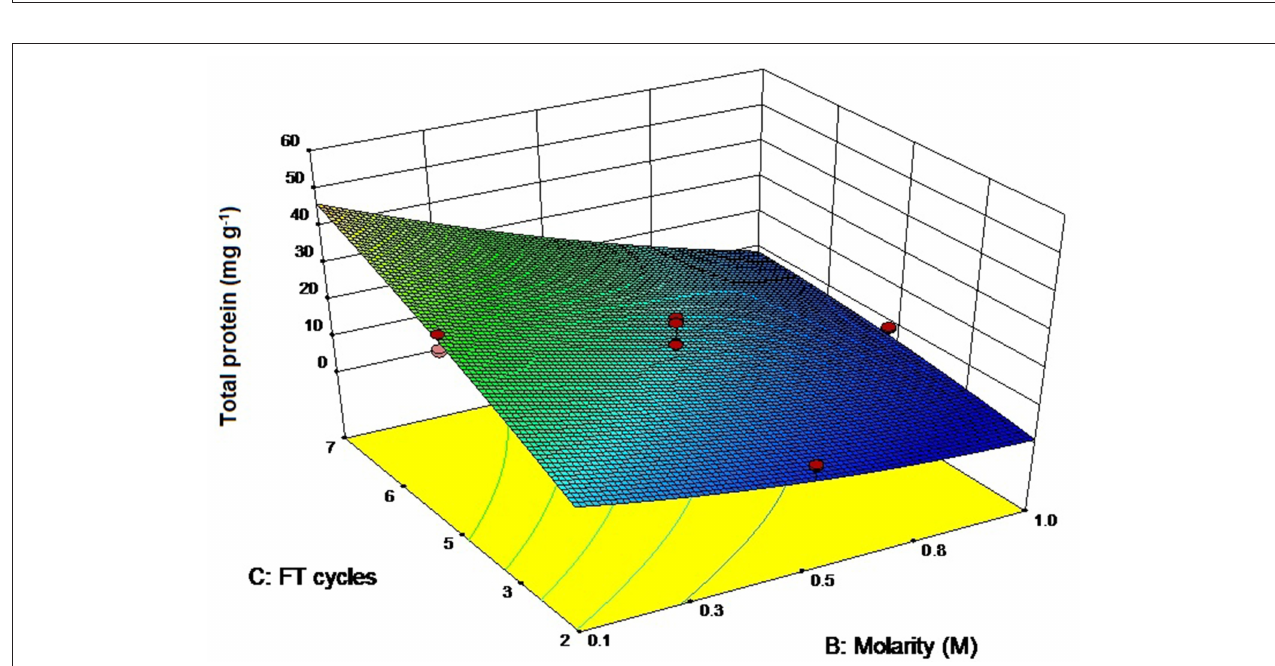
FIGURE 4 | Three-dimensional plot of interaction between freeze thaw cycles and buffer molarity for total protein extraction.